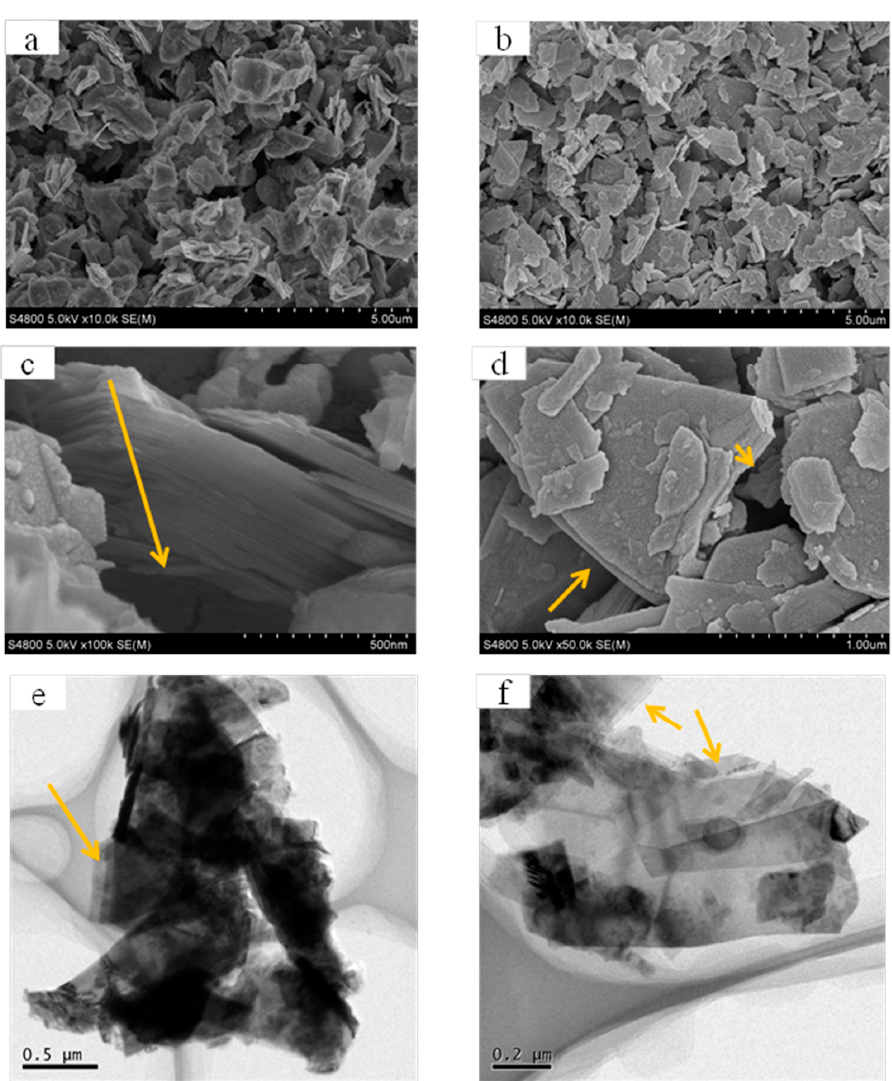
Figure 2. SEM images of original commercial MoS 2 ( a , c ) and MoS 2 after 4 h of sonication ( b , d ), TEM images of original commercial MoS 2 ( e ), and MoS 2 after 4 h of sonication ( f ).